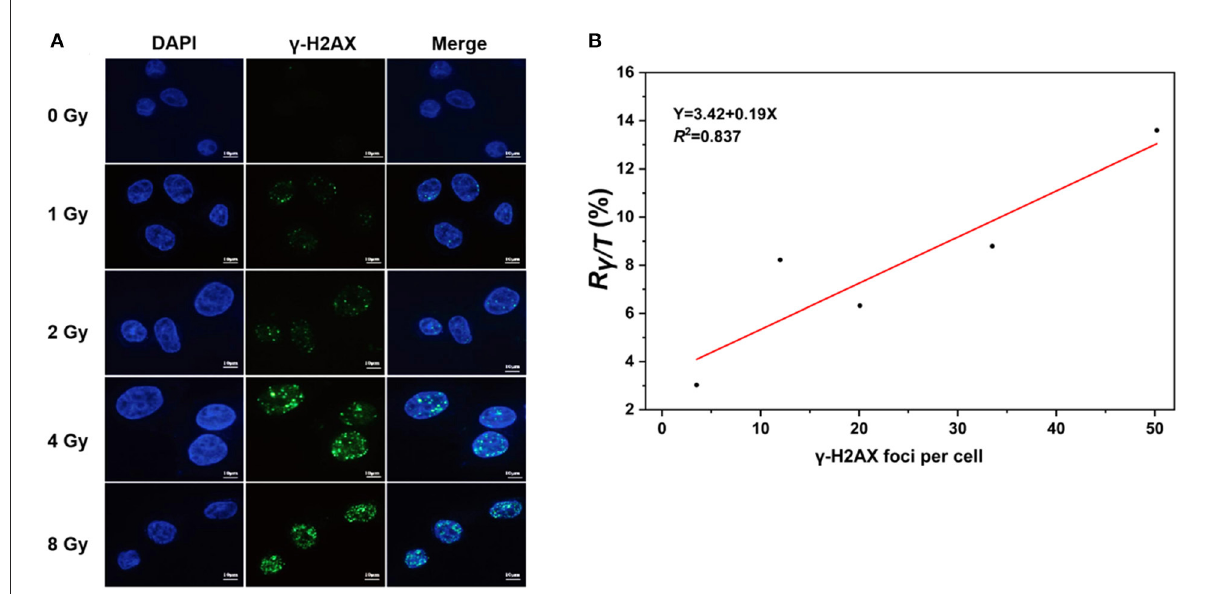
FIGURE4 Correlation analysis of immunofluorescence and LC–MS/MS methods for the measurement of γ -H2AX, (A) γ -H2AX foci of immunofluorescent staining in AHH1 cells exposed to γ -ray in the dose range of 0–8Gy at 0.5h post-irradiation, and (B) the correlation analysis of immunofluorescence and LC–MS/MS in AHH1 cells exposed to γ -ray in the dose range of 0–8Gy at 0.5h post-irradiation.